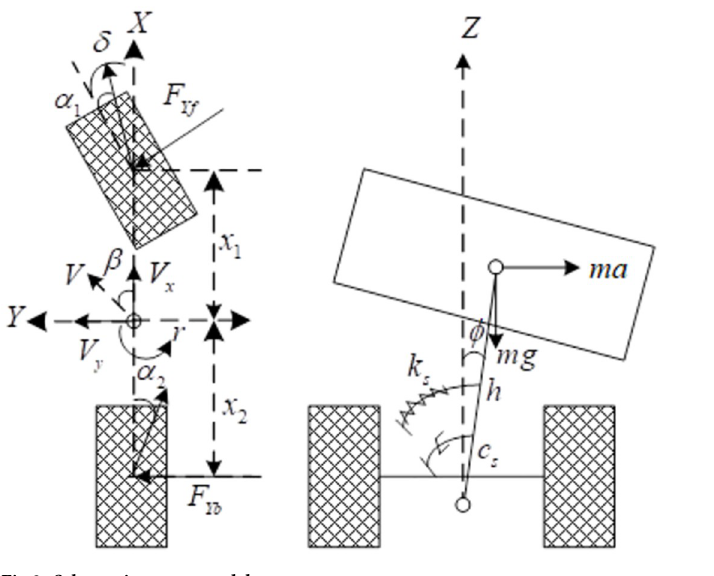
Fig 2. Schematic cosver